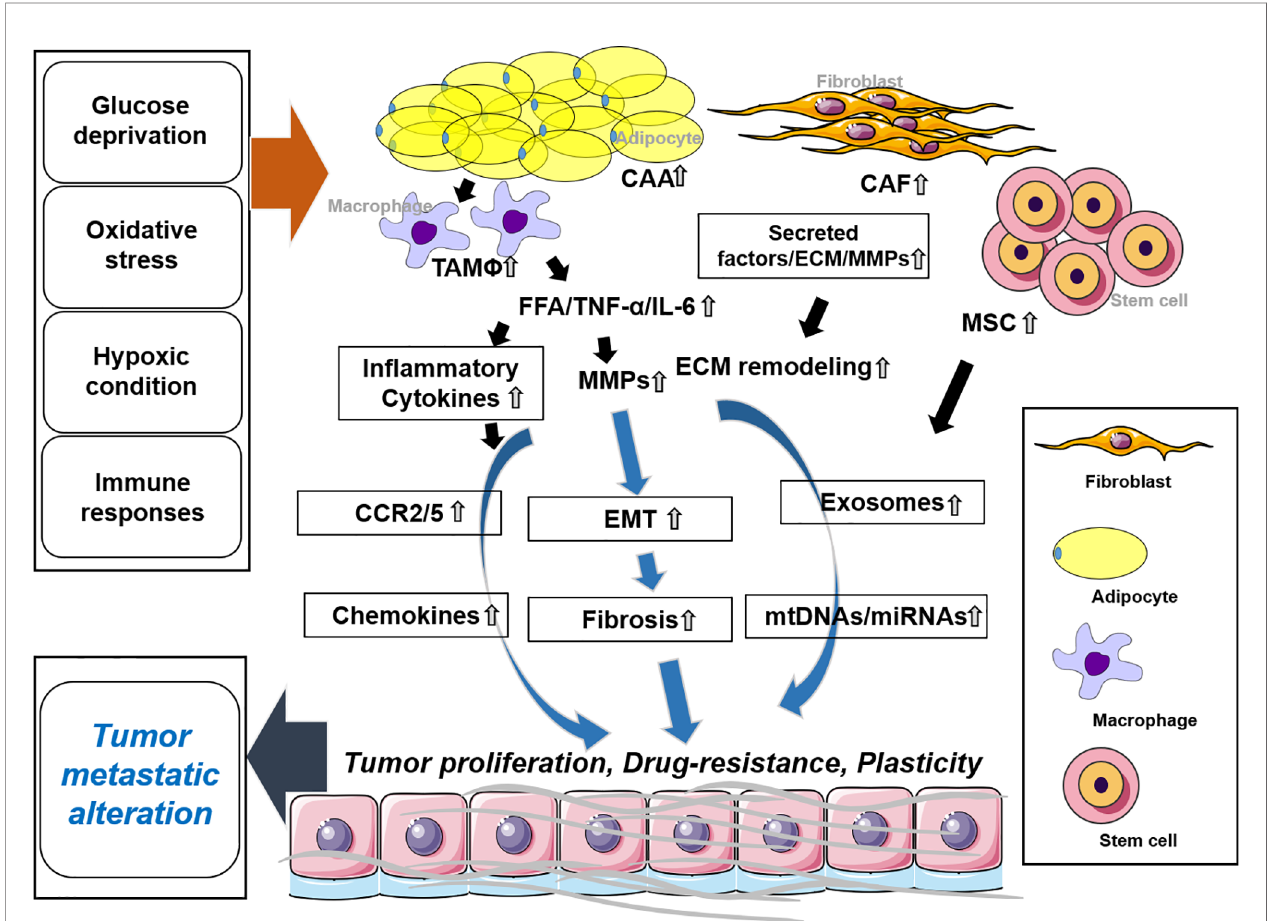
FIGURE 2 | Stromal cells and the tumor microenvironment. CAA regulates EMT by secreting tumor necrosis factor (TNF)- a , IL-6, and FFA along with MMPs. In fl ammatory cytokines are secreted by TAM and trigger chemokines. In CAF release, secreted factors and MMPs promote ECM remodeling. MSCs secrete exosomes along with mtDNAs and microRNAs (miRNAs). These molecules synergistically or individually promote tumor proliferation, drug resistance, and plasticity and affect tumor metastatic alteration. CAA, cancer-associated adipocytes; CAF, cancer-associated fi broblast; MSC, mesenchymal stem cell; TAM, tumor-associated